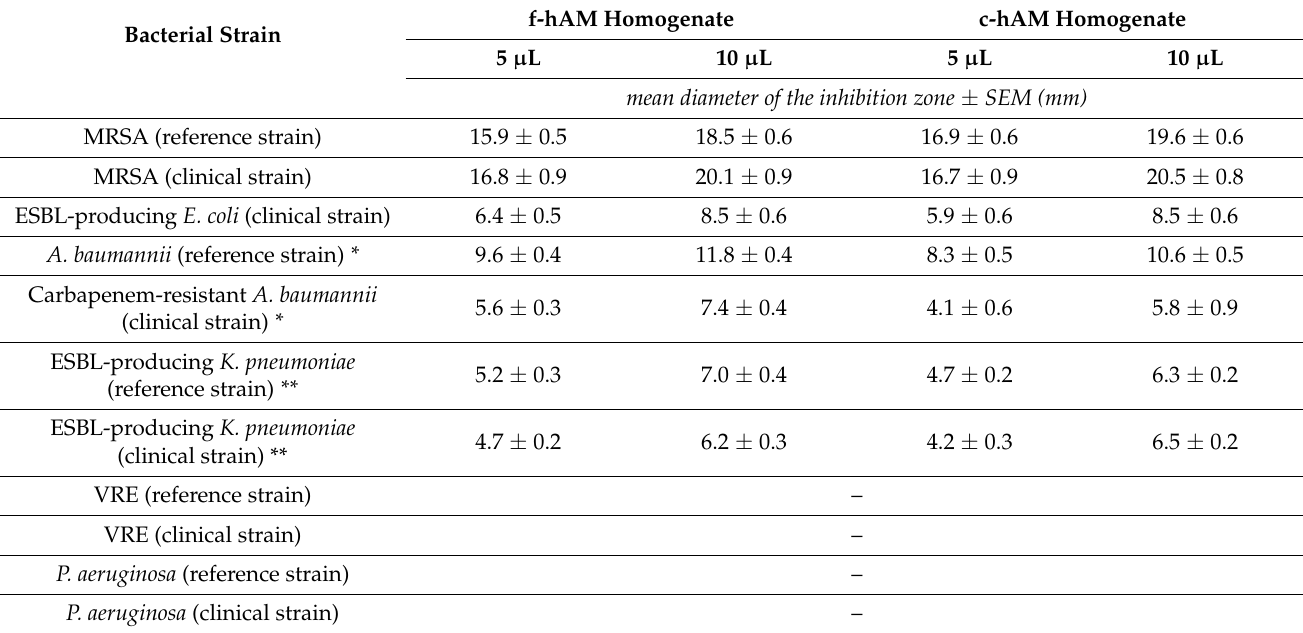
Table 2. The range of antibacterial activity of f-hAM and c-hAM homogenates varies between multidrug-resistant strains. f-hAM Homogenate c-hAM Bacterial Strain